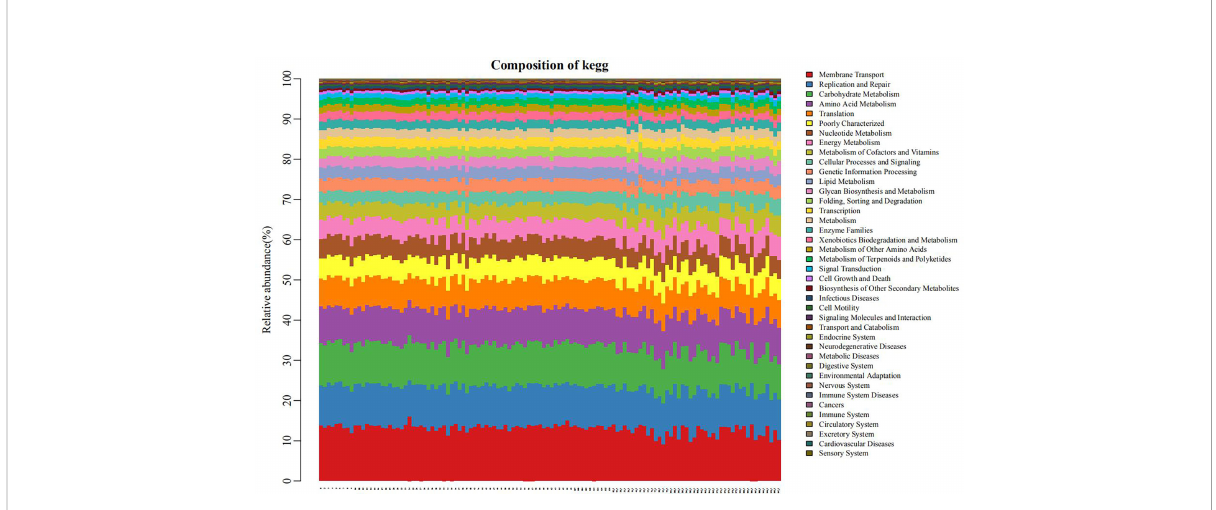
FIGURE 6 Bar diagram of the distribution of pathways and functions (the left two-thirds of the abscissa: plateau group, the right third: plain group.) Each position on the horizontal axis represented separate object. Different colors indicated different pathways or functions, and the length of each color stripe indicated the proportion of a particular pathway (function) in